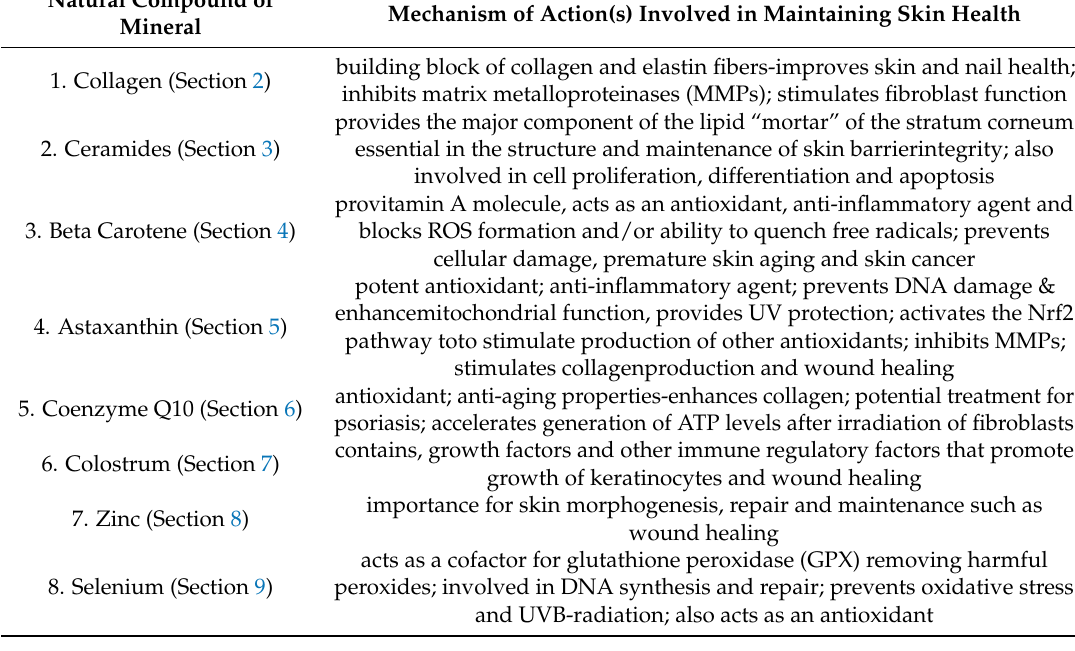
Table 1. Summary of all natural compounds and minerals covered in this